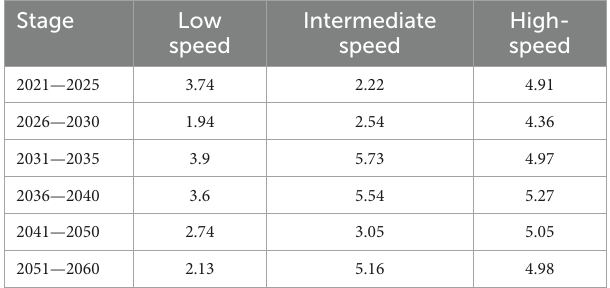
TABLE 1 Annual GDP growth forecast.